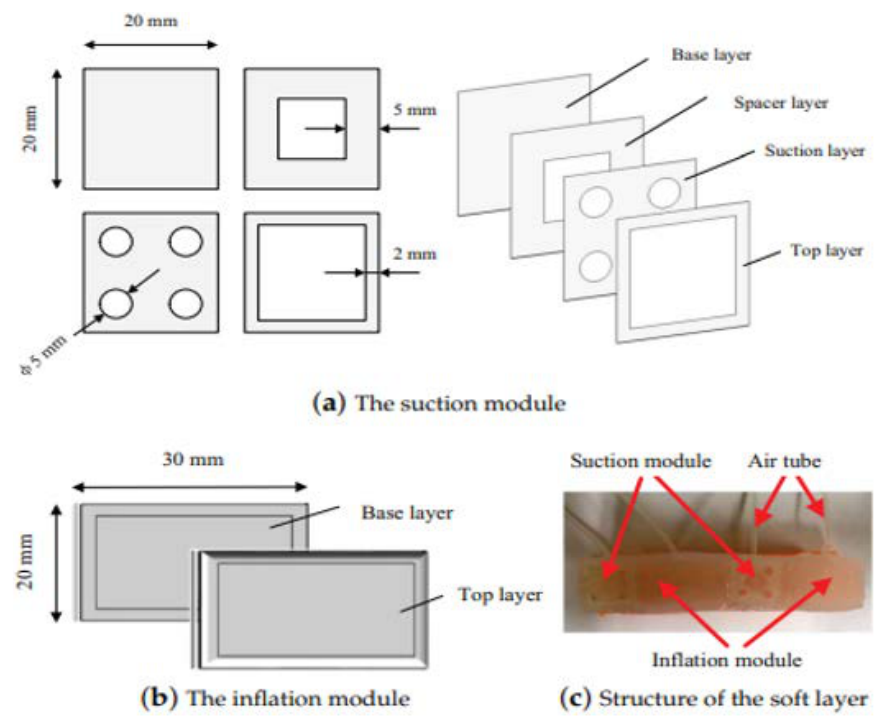
Figure 5. ( a ) shows the dimensions as well as a breakdown of this soft layer’s composition. It is comprised of a basic layer, then a spacing layer, followed by the suction layer, and ends with a soft top layer. ( b ) shows the inflation module in greater detail and with its dimensions, it has a simpler composition of a base and then layers. ( c ) shows the structure in real time, breaking down where what the suction and inflation modules look like, as well as pointing out the air tubes to allow for the inflation modules’ actuation (Reprinted with permission from Zhu, G. et al. [36]. Copyright 2020, CC BY 4.0 International).